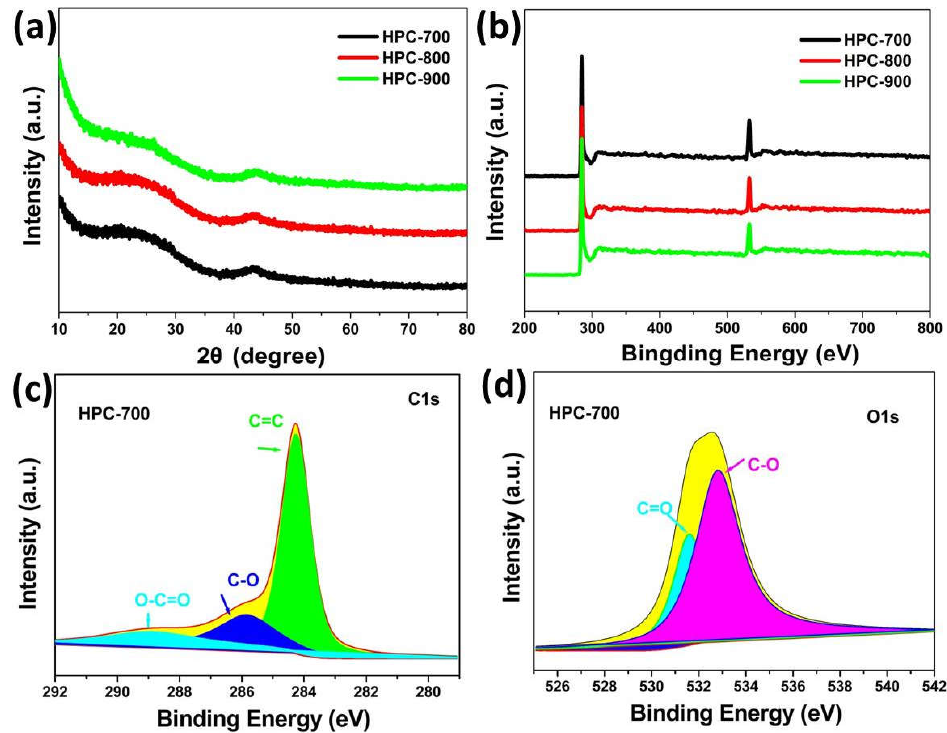
Figure 4. ( a ) XRD patterns and ( b ) XPS survey spectra of HPC-700, HPC-800, and HPC-900; ( c ) C1s and ( d ) O1s spectra of HPC-700.